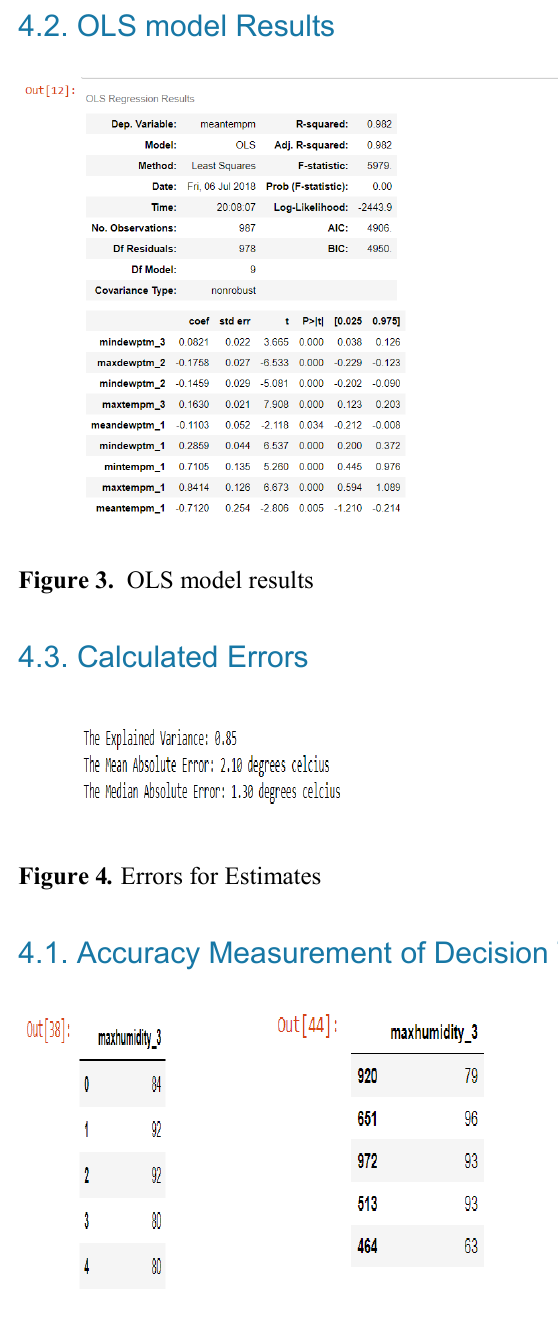
Figure 5. Select features Figure 6. Trained data